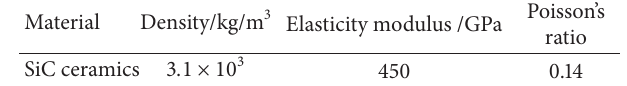
Table 3: The materials of the solid domain and the corresponding physical property parameters.